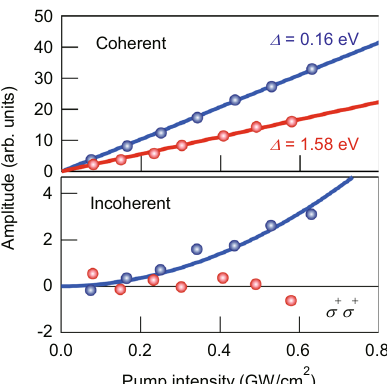
Fig. 4 Dependences of the coherent and incoherent components on the detuning energy Δ . The amplitudes of coherent and incoherent components estimated from the transient absorption signals in the σ + σ + con fi guration are shown in the top and bottom panels, respectively. The data are provided as a function of the pump intensity for Δ = 0.16 (blue circles) and 1.58 eV (red circles). The solid lines in the top panel describe a linear dependence on the pump intensity and the solid curve in the bottom panel represents a square